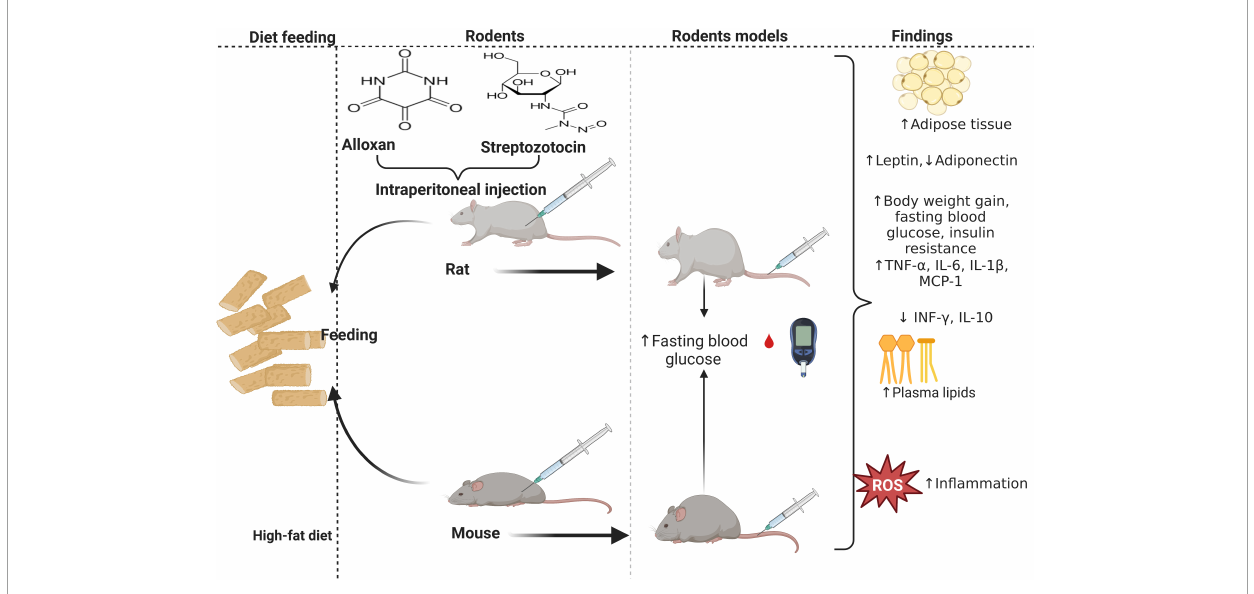
FIGURE1 The effect of a high-fat diet (HFD) on inflammation and insulin resistance during obesity. HFD-fed mice develop while rats fed HFD concomitant to intraperitoneal injection of alloxan monohydrate or streptozotocin (STZ) develop diabetes. Rodents with diet-induced obesity or diabetes have enlarged adipocytes, elevating pro-inflammatory cytokines, adipokines, and lipid profiles, concomitant to decreased anti-inflammatory cytokines and